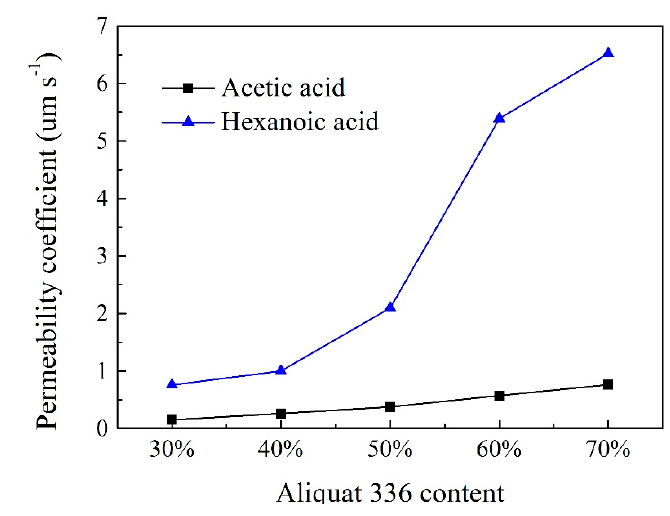
Figure 5. The permeability coefficient of acetic and hexanoic acid by PIMs with different Aliquat 336 content (PIMs: PIMs: PIM1, PIM2, PIM3, PIM4, and PIM5; Feed solution: 0.01 mol L − 1 acetic acid + 0.01 mol L − 1 hexanoic acid, pH = 6; Stripping solution: 0.1 mol L − 1 HCl).